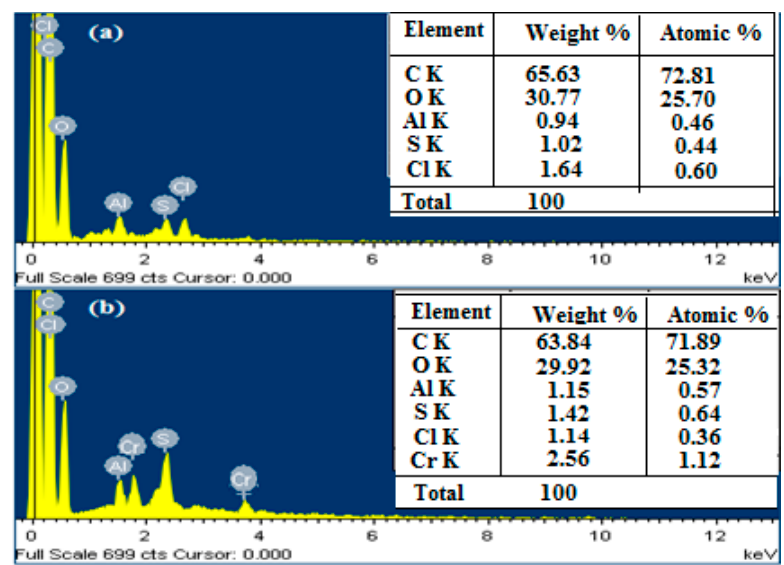
Figure 3. EDX Images of Al-GNSC: ( a ) before, and ( b ) after Cr(VI) adsorption.